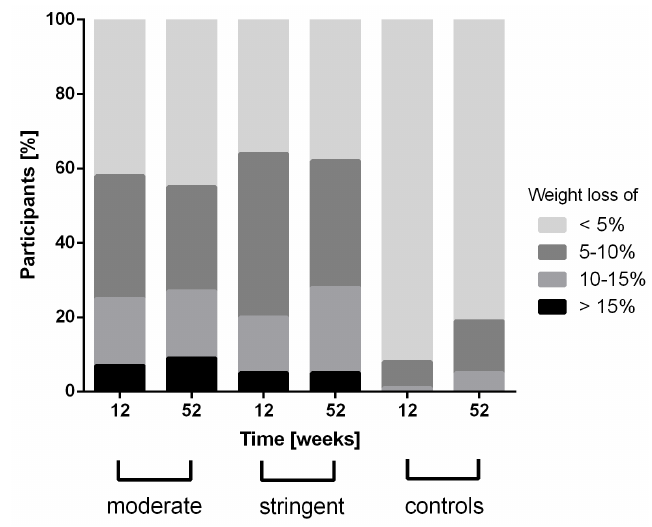
Figure 2. Weight change achieved after 12 and 52 weeks of intervention. Analyses of difference in frequency distribution of weight loss were calculated by using Fisher’s exact test.